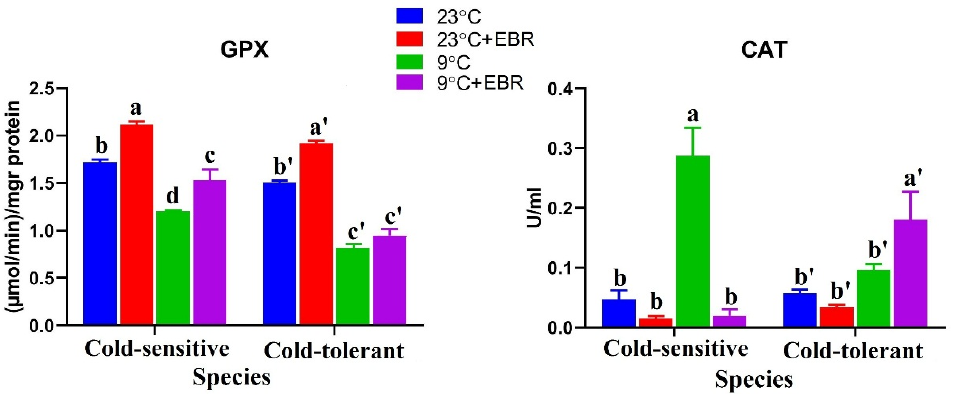
Figure 4. The profile of GPX and CAT activity under low-temperature stress and EBR treatment.